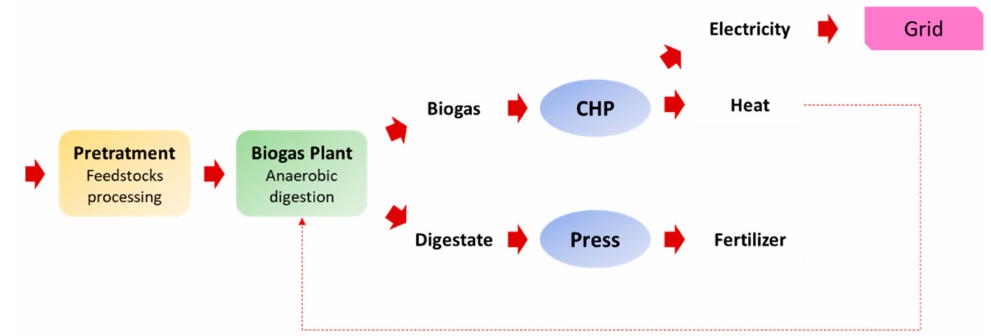
Figure 1. Schematic overview of the biogas-based power